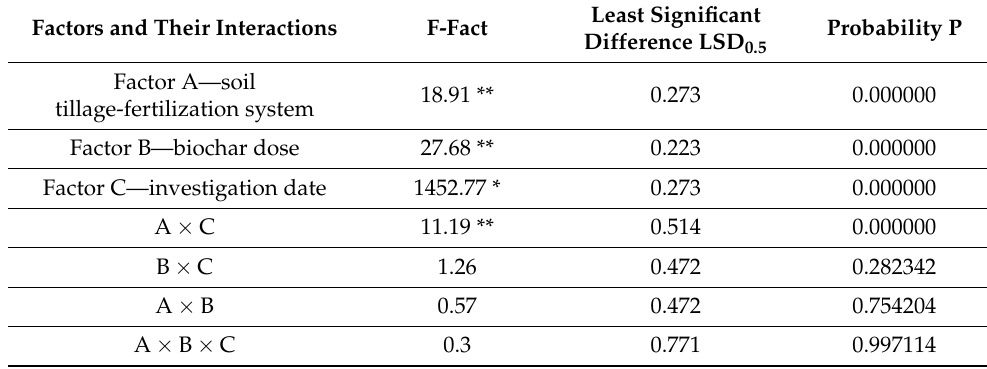
Table 6. Variance analysis of soil moisture content, n = 3.